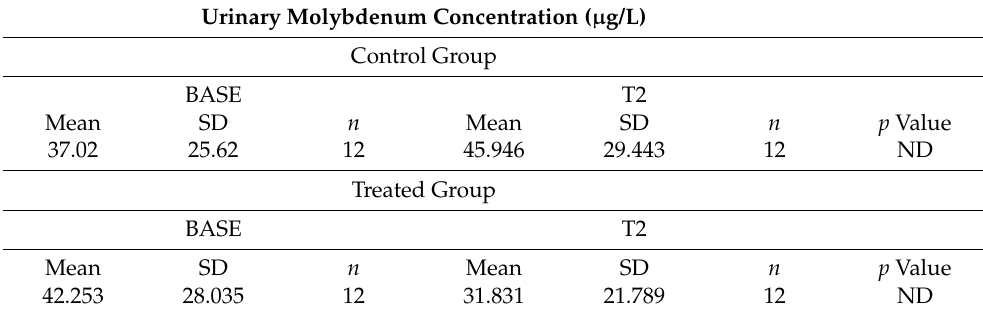
Table 3. Urinary molybdenum levels measured at baseline (BASE) and after 12 days of lettuce consumption (T2) in the control and in the treated group. ND = not statistically different from each other. Values are means ± SD. n = 12 in each group.